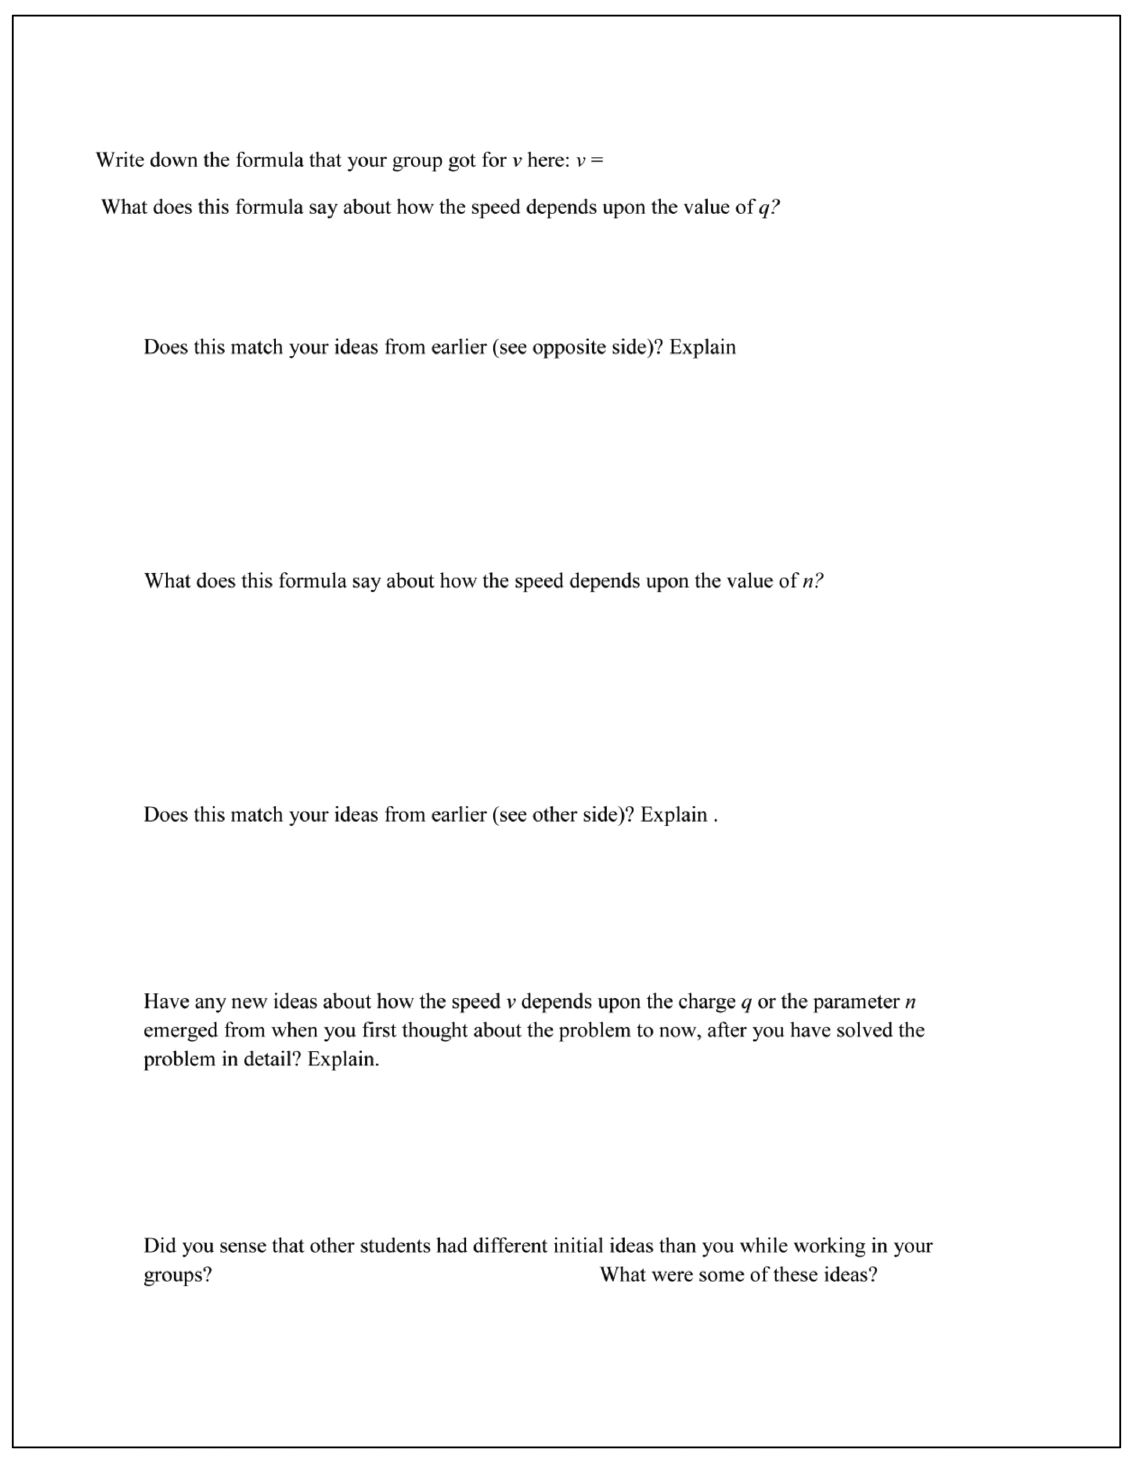
FIG. 21. Magnetic field around a conducting cylinder problem referenced in Fig. 11, layer